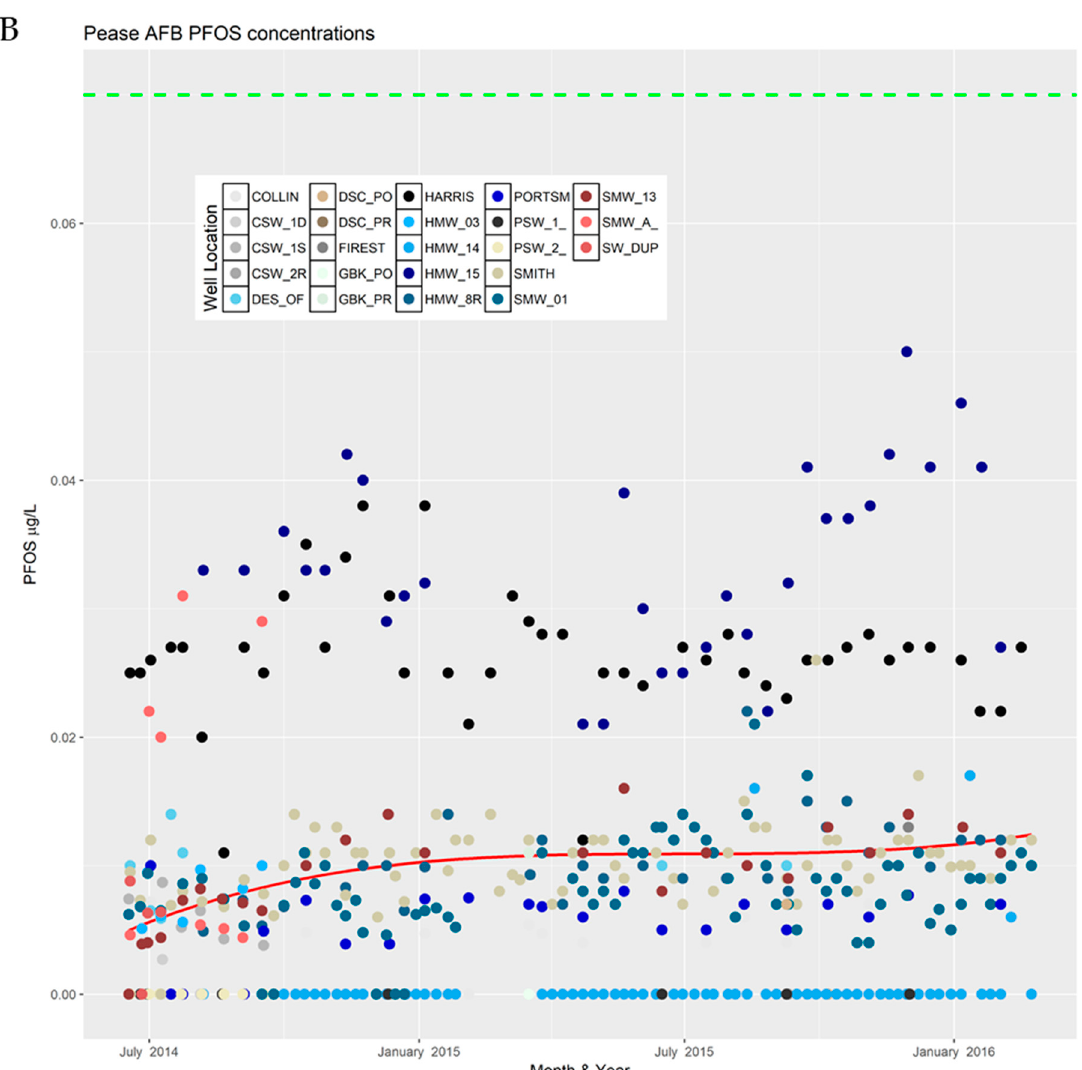
Figure 2. The above chart shows the variance in perfluorooctanesulfonic acid (PFOS) concentrations, over 8 months at, two different military installations. ( A ) Alaska military base; ( B ) Pease AFB. Missing data were excluded from the plots. Because of the numerous data points for the Pease data, only points representing concentrations above 0.02 µ g/L were labeled on the plot.